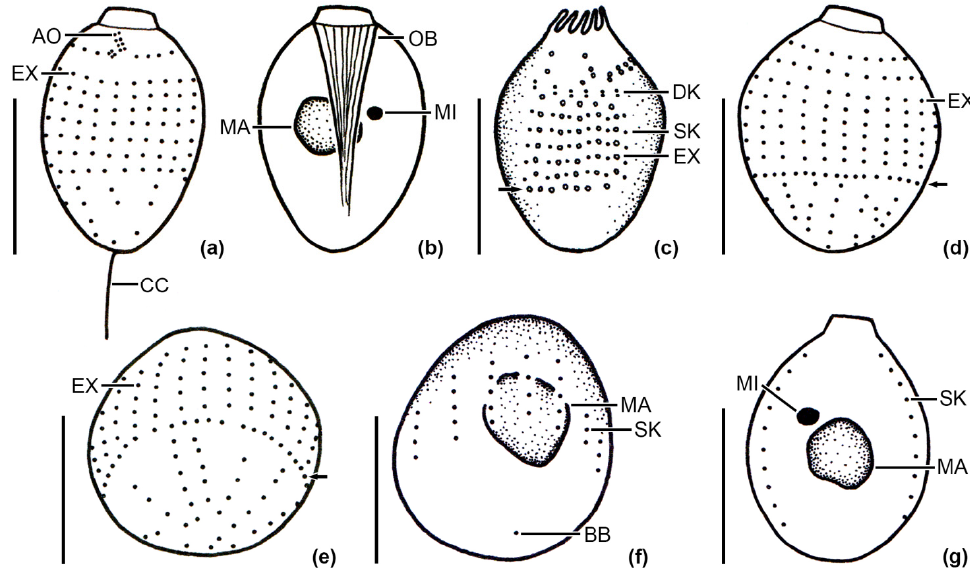
Figure 2. Species tentatively assigned to Urotricha globosa from Lake Hairlach ( a – e ) and Urotricha nais from Lake Faselfad ( f , g ) after protargol staining. ( a , d , e ). Ventral, dorsal and oblique posterior polar views. Note that the extrusomes and not the basal bodies of the ciliary rows are shown except for the adoral organelles and the caudal cilium in ( a ). Extrusomes are arranged longitudinally between the ciliary rows and in vertical rows in the unciliated posterior portion ( e ); note the horizontally more densely arranged extrusomes at the end of the ciliated area (arrows) in ( c – e ). ( b ) Optical section showing the anterior protruding oral region and the nuclei. ( c ). Details of the cell cortex showing the extrusomes (illustrated by circles) located between the somatic kineties (exemplarily, only a section of the total ciliature is shown). ( f , g ) Details of the infraciliature and nuclei; note that in ( f ) not the total length and the correct number of basal bodies of the somatic kineties is shown and in the schematic overview in ( g ), only two somatic kineties are exemplarily shown. AO—adoral organelles, BB—basal body of the single caudal cilium, CC—caudal cilium, DK—dikinetids at anterior end of somatic kineties, EX—extrusomes, MA—macronucleus, MI—micronucleus, OB—oral basket, SK—somatic kineties. Arrows denote singular dense extrusome row at the posterior end of the somatic ciliary rows in Urotricha globosa . Scale bars 10 µ